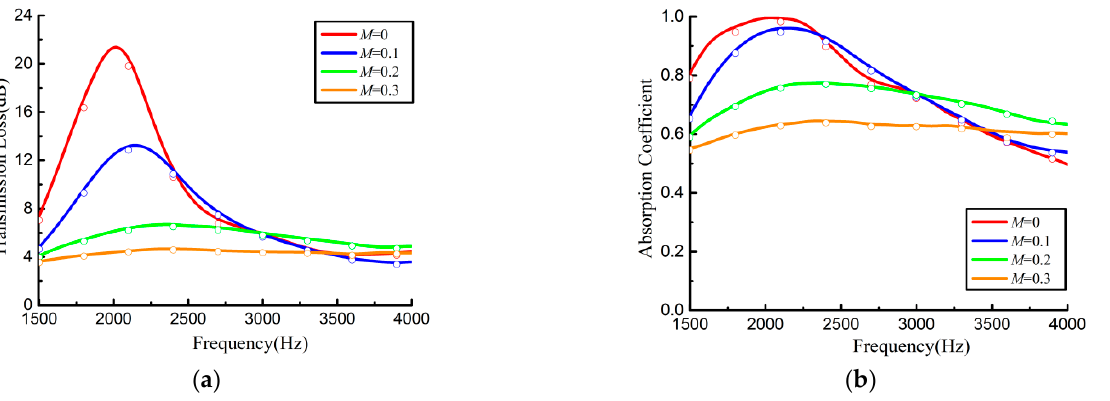
Figure 18. Comparisons of transmission loss and absorption coefficient of the RDPAA system under different grazing flow Mach numbers. The solid lines represent the results computed by the IBNSE method with Goodrich model, while the circles represent the results computed by the FNSE method. ( a ) Transmission loss and ( b ) acoustic absorption coefficient.